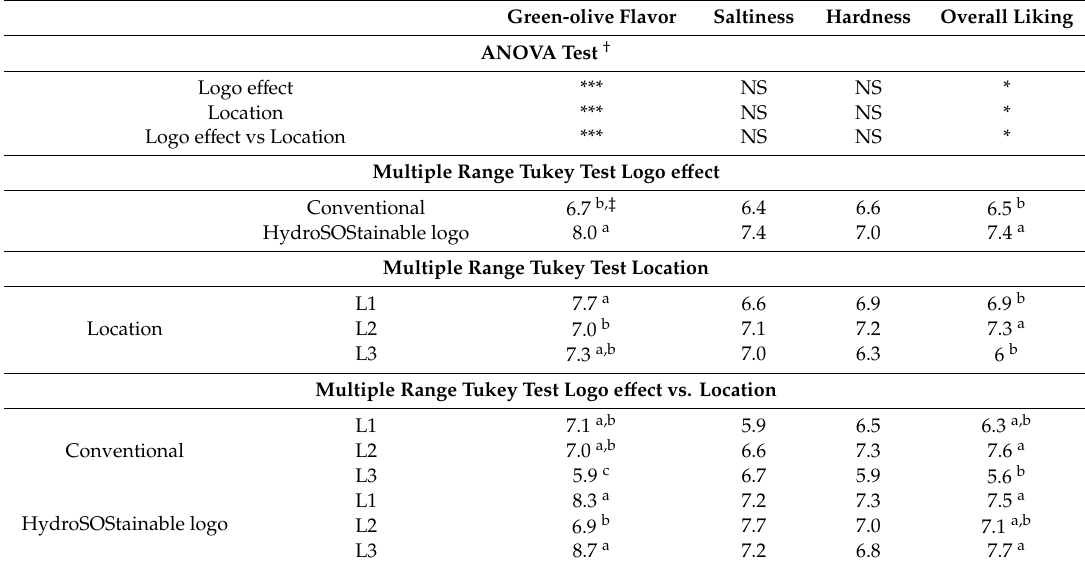
Table 5. Overall liking and satisfaction degree on flavor, saltiness and hardness of Table Olives a ff ected by logo e ff ect and